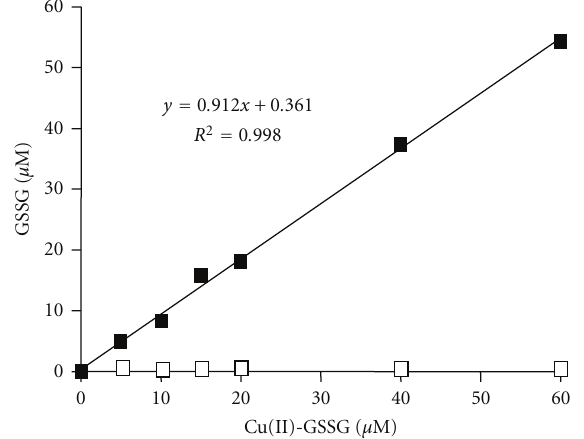
Figure 4: Assessment of GSSG by the EDTA-modified NADPH/- glutathione reductase assay: correlation between GSSG and Cu(II)- GSSG. NADPH (0.2mM), glutathione reductase (2U/mL), and EDTA (2mM) were added to solutions containing increasing concentrations of the Cu(II)-GSSG complex (5–60 μ M). Results are expressed as μ M GSSG concentration. The symbols represent: solutions containing the Cu(II)-GSSG complex (5–60 μ M) assayed in the presence ( (cid:3) ) or in the absence of EDTA ( (cid:5) ).